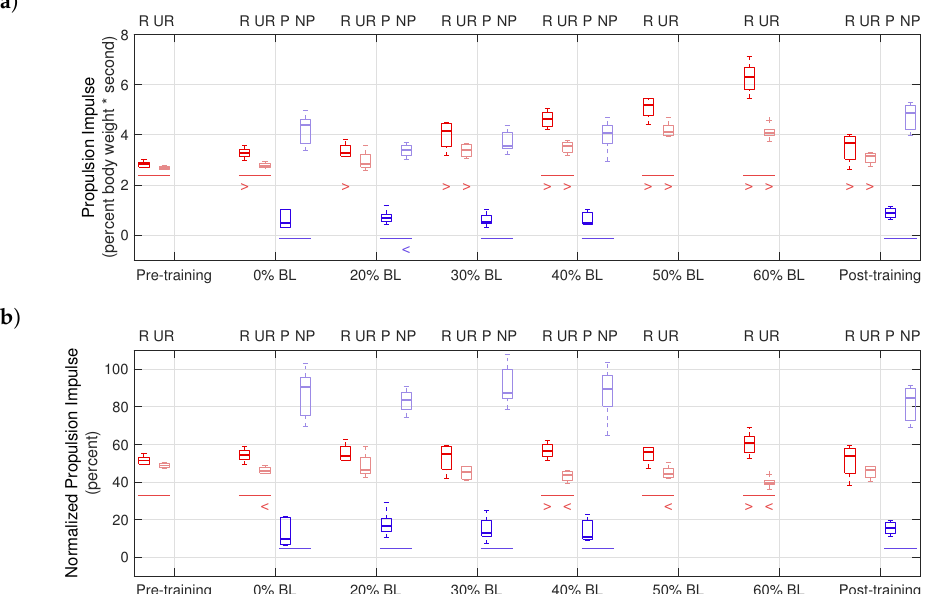
Figure 12. Raw and normalized propulsion impulses in the pilot study. ( a ) Propulsion impulses. ( b ) Propulsion impulses normalized by sum of median